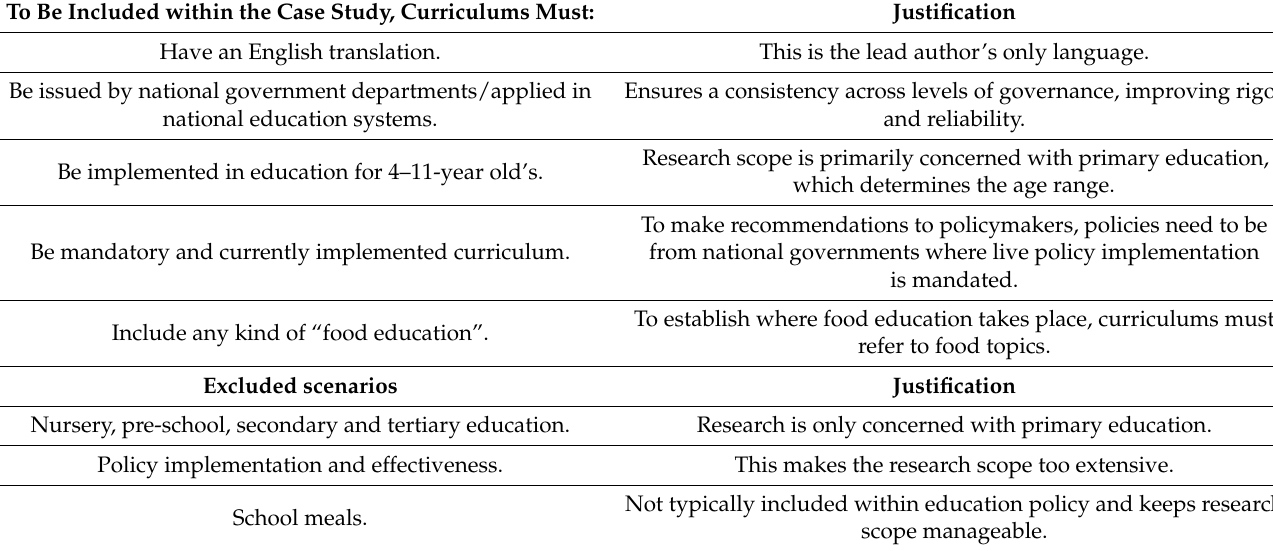
Table 2. Inclusion and exclusion criteria. Source: